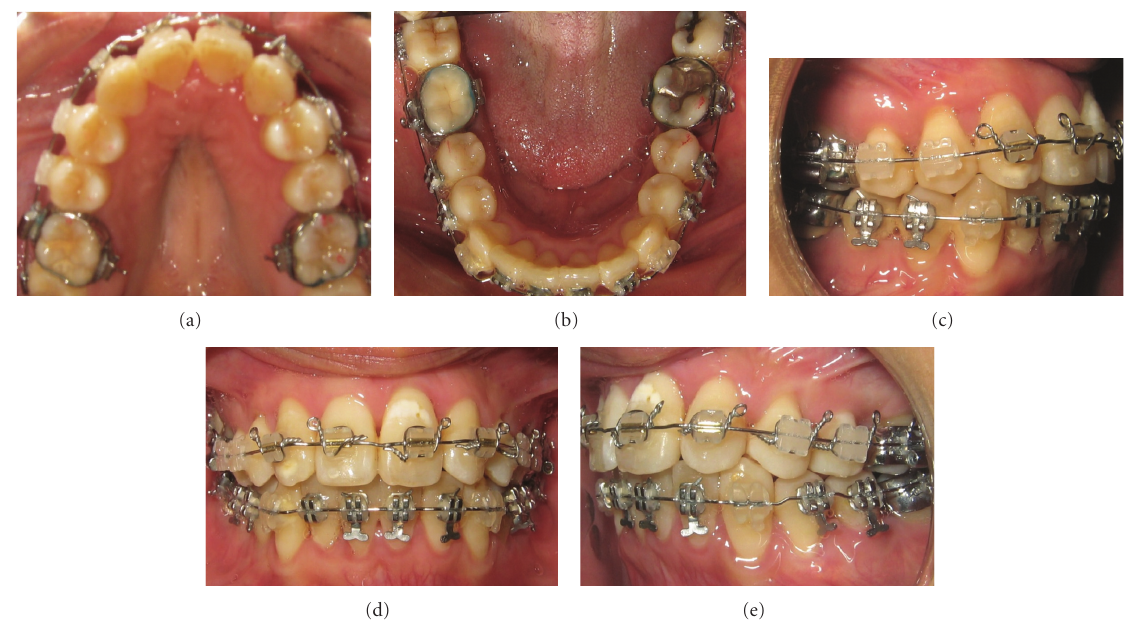
Figure 8: Intraoral photographs 28 weeks after